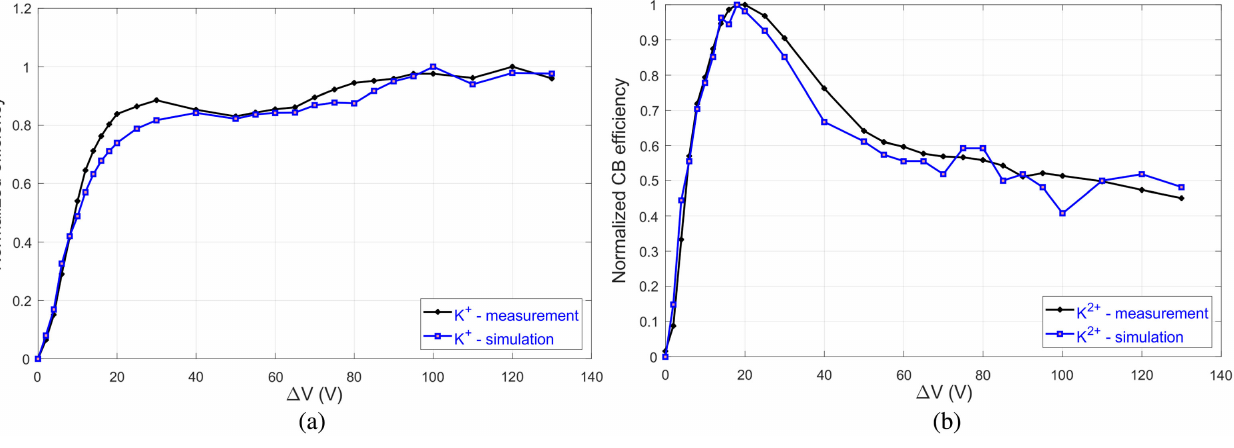
FIG. 12. Comparison of simulated and experimental (a) K 1 þ and (b) K 2 þ Δ V curves obtained from O 2 plasma parameters. n 1 . 5 × 10 11 cm − 3 (for 209 W of rf power) and k T